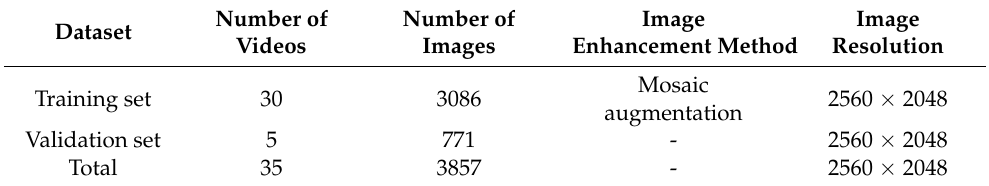
Table 1. The explanation of the